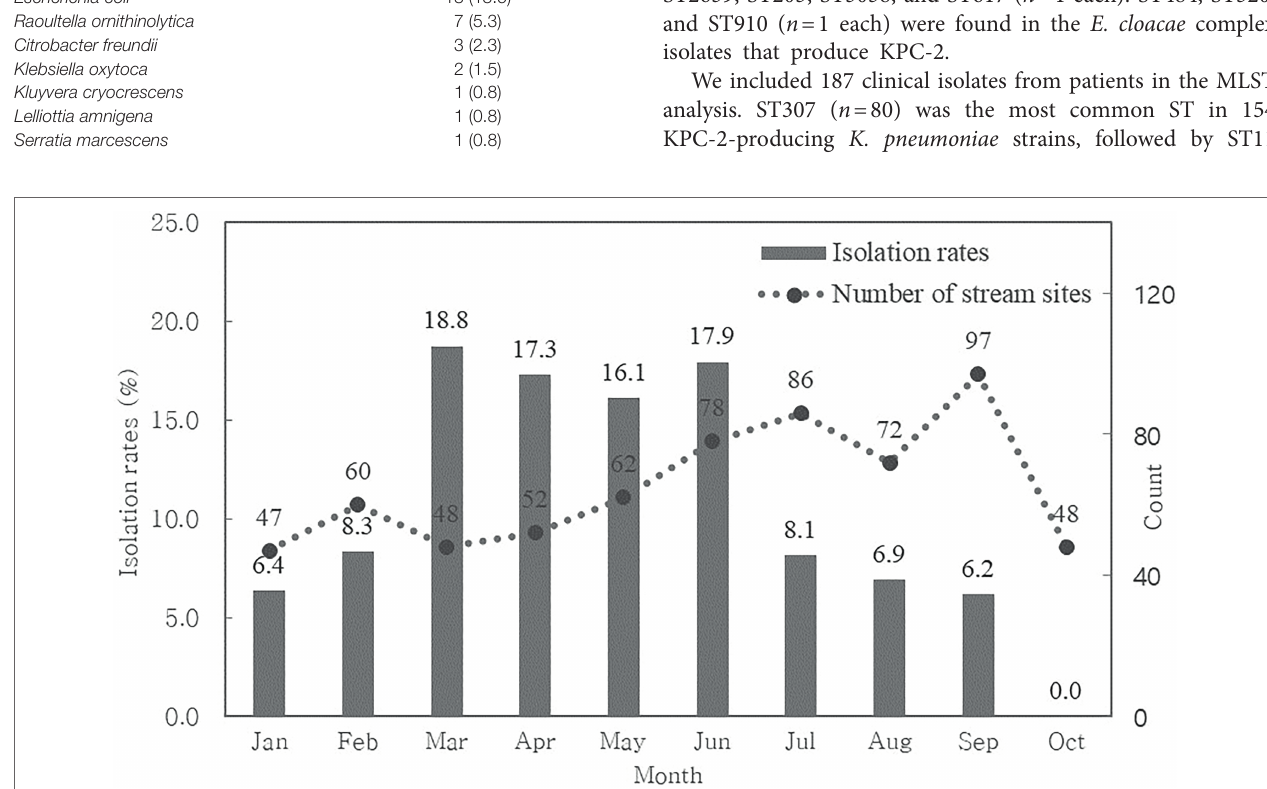
TABLE 2 | Distribution of carbapenem-resistant Enterobacterales isolates from streams. Species No. (%) of isolates Klebsiella pneumoniae